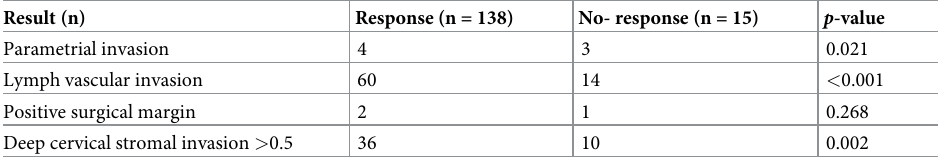
Table 2. Comparison of pathology results within NACT-RS group.